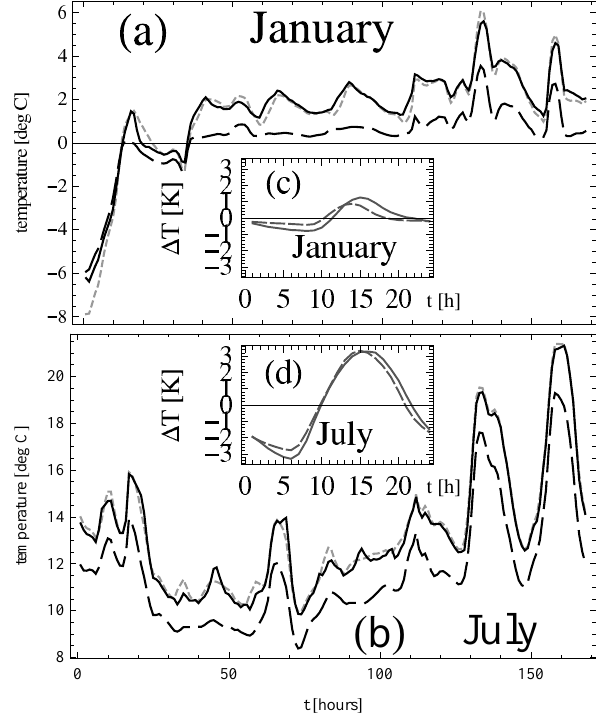
Fig. 10. Original and corrected hourly time series for one week in January ( a ) and July ( b ), long-dashed line is original model data, solid line is cascade-corrected model data, short-dashed line is data corrected using standard method; Inset: Diurnal cycle for January ( c ) and July ( d ) for model (dashed) and observations (solid), respectively.